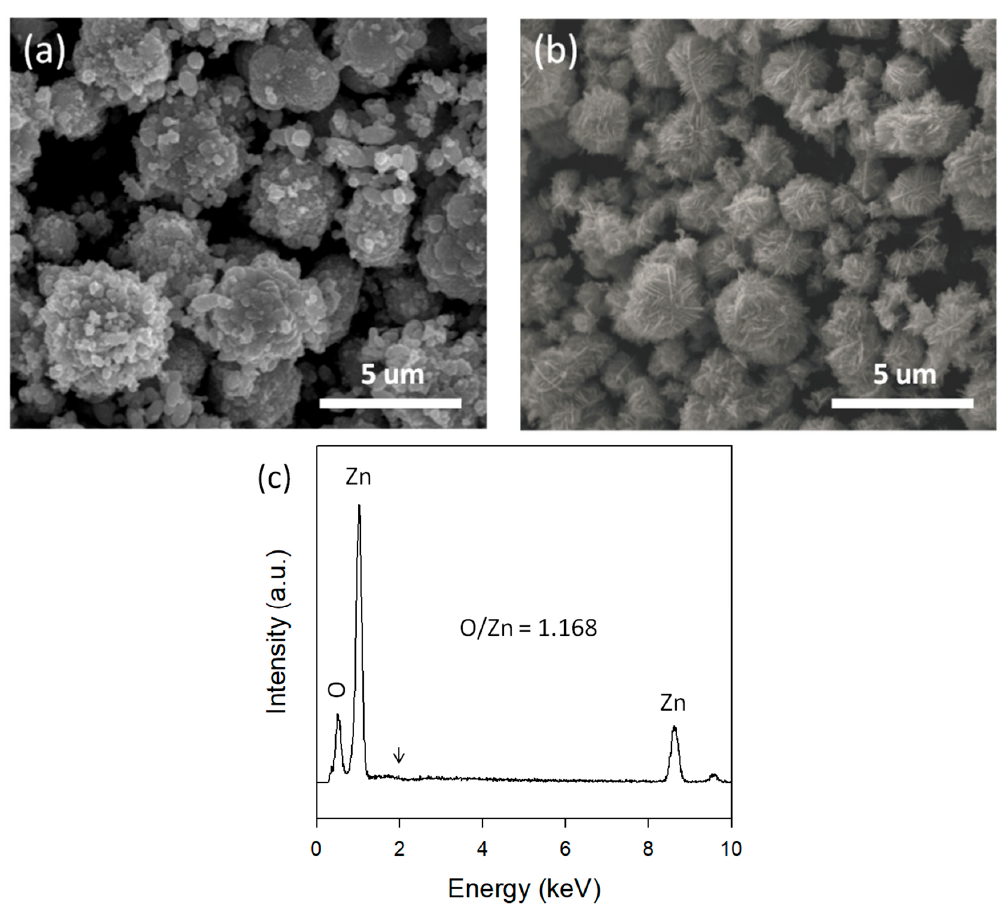
Figure 1. SEM images of ( a ) Au-ZnO-CP and ( b ) Au/ZnO synthesized in a micro-reactor. ( c ) EDS spectrum of Au/ZnO synthesized in a micro-reactor (arrow at ~2.2 keV represents the X-ray signals of the Au-L1).